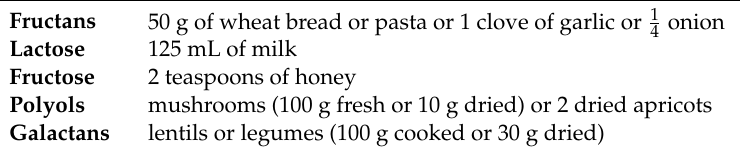
Table 3. FODMAP reintroduction: the foods suggested as trigger foods for each FODMAP group and their suggested amount are